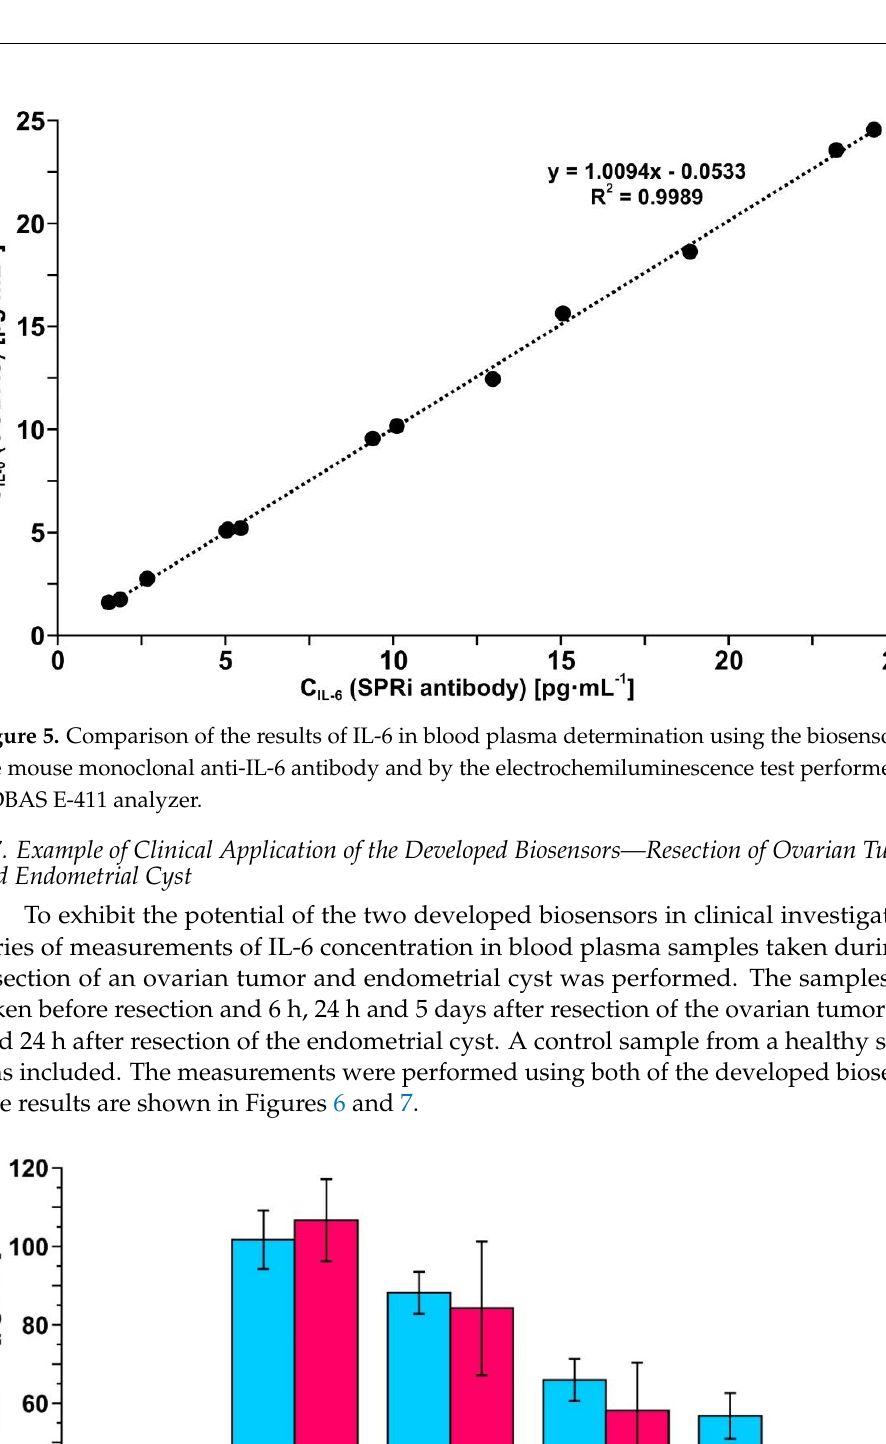
Figure 7. Changes in IL-6 concentration in the blood plasma of a patient before and after resection of endometrial cyst, as determined by the biosensor with the antibody as the receptor (blue) or the biosensor with the inhibitor as the receptor (red). A: control, B: before resection, C: 5 h, and D: 24 h hours after resection. Both developed biosensors exhibit good selectivity, as is evidenced in a series of ex- periments with potential interferents: albumin, CEA, CA 125, leptin and MMP2. The re- sults are shown in Table 1 for the biosensor with mouse monoclonal anti- IL-6 antibody as a receptor and in Table 2 for the biosensor with the galiellalactone receptor. Apart from albumin, which is present in human blood in excess, the selection of the other interferents was somewhat random. The recoveries do not exceed 100 ± 4% for either biosensor. How- ever, selectivity is best examined by means of experiments with blood plasma, which con-